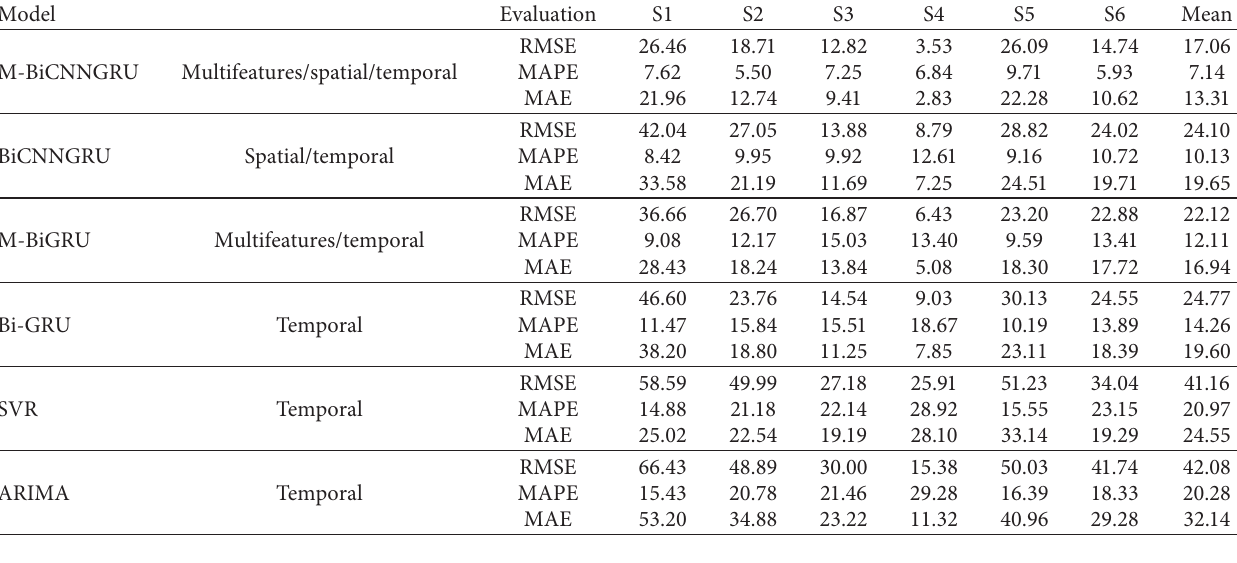
Table 5: The RMSEs, MAPEs, and MAEs of various